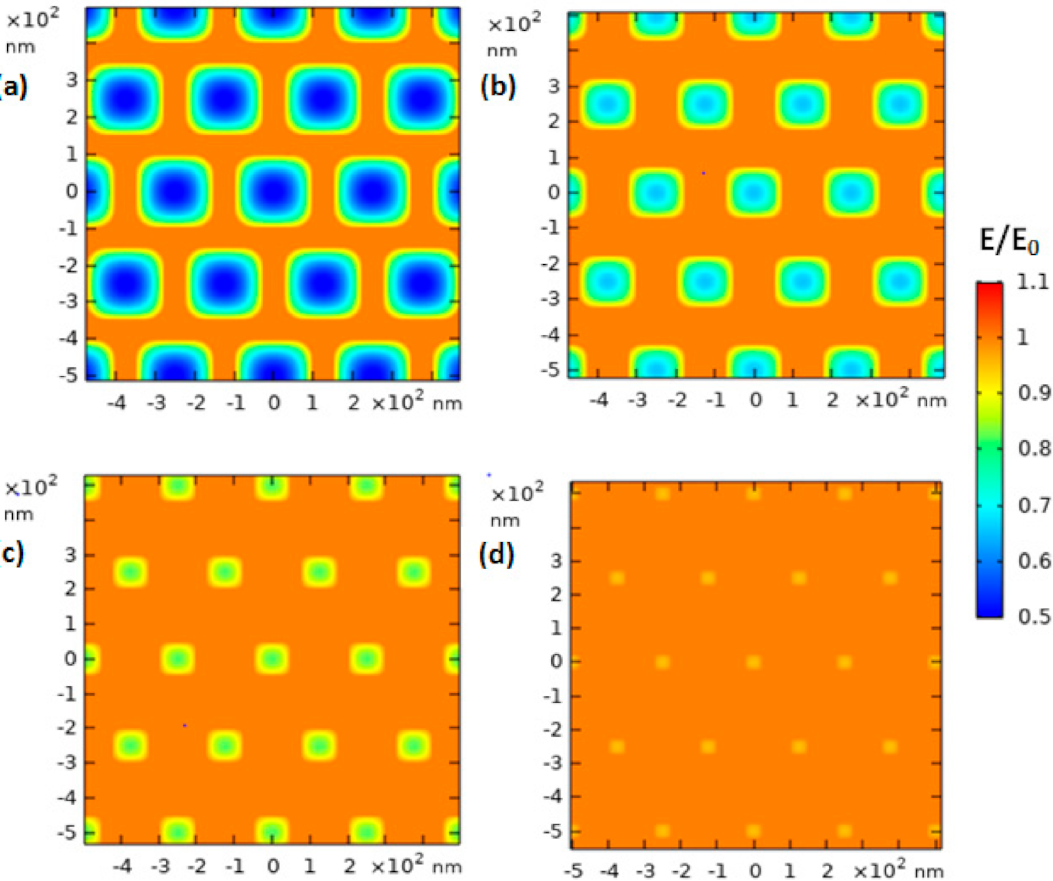
Figure 7. A top view of the FDTD simulation of the photoanode of the CuWO 4 nanorod arrays toward EM waves with a wavelength of 420 nm for each of the samples of the photoanode of the CuWO 4 nanorod arrays with distinct gaps between the CuWO 4 nanorod arrays of ( a ) 50 nm, ( b ) 100 nm, ( c ) 150 nm, and ( d ) 200